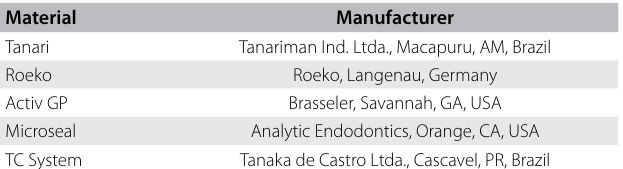
Table 1. Endodontic filling materials